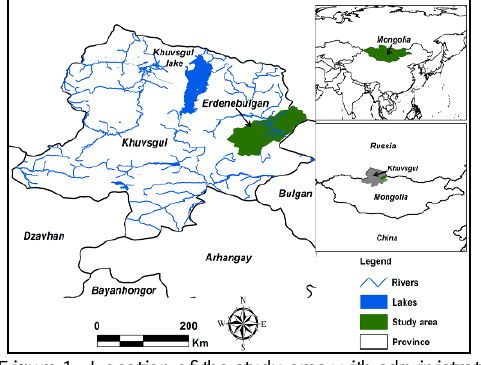
Figure 1. Location of the study area with administrative boundaries of provinces